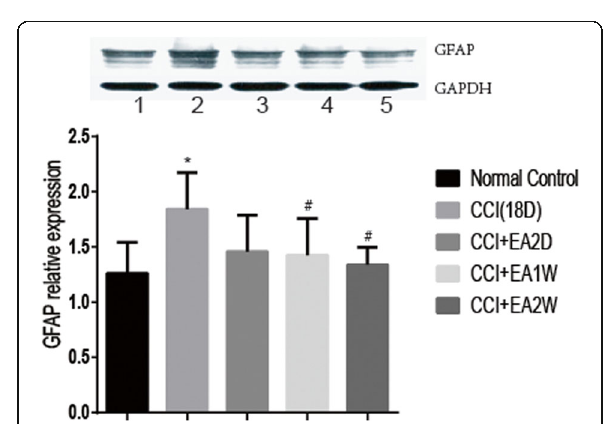
Fig. 6 Quantitative analysis of expression levels of GFAP protein in the dorsal part of the lumbar spinal cord in rats of the five groups. Upper panel: representative western blot stripes of the 5 groups. 1: control, 2: CCI(18D), 3: CCI + EA2D, 4; CCI + EA1W, 5:CCI + EA2W. Lower panel: bar graphs showing the expression levels of GFAP protein in the 5 groups, five rats in each group were examined and the data are expressed as mean ± SD. * P < 0.05, vs the control group; # P < 0.05, vs the CCI